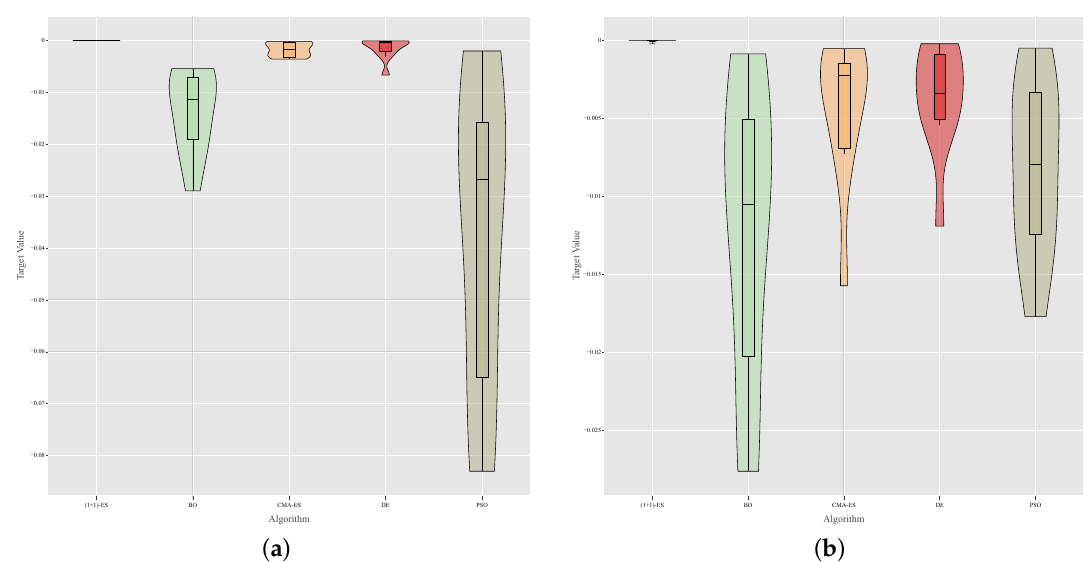
Figure 8. Empirical probability density functions of the final fitness values registered by the executions of each algorithm estimated using the Kernel Density Estimation methodology [55]. ( a ) Case study 1—River Paglia; ( b ) Case study 2—River